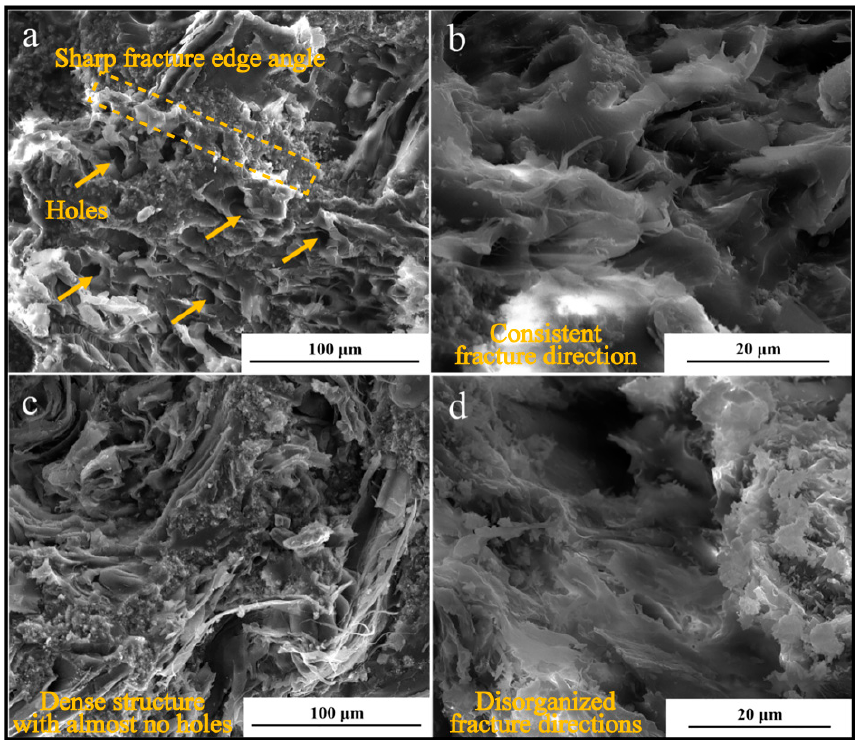
Figure 12. Section morphology: ( a ) UMPR section morphology at 1200×; ( b ) UMPR section morphology at 5000×; ( c ) 40% MTMS modified SMPR at 1200×; ( d ) 40% MTMS-modified SMPR at 5000×.